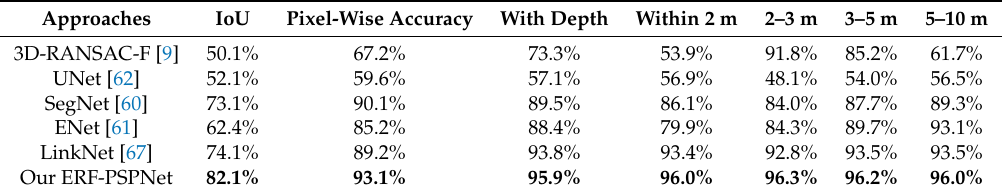
Table 4. On the real-world TerrainAwarenessDataset [71] in terms of traversable area parsing. “With Depth”: Only the pixels with valid depth information are evaluated using pixel-wise accuracy.